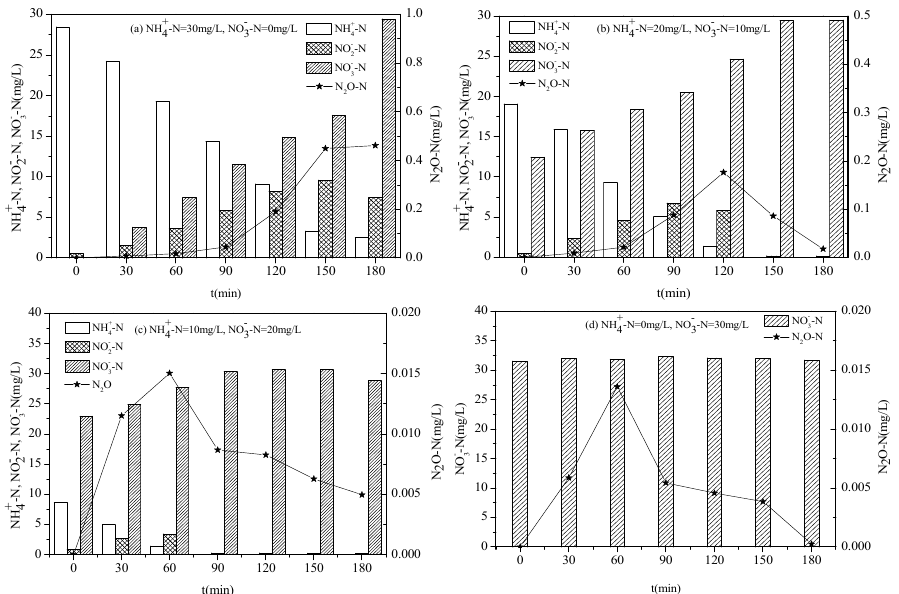
Figure 3. N 2 O emission during full nitrification (full nitrification effluent +NH 4 Cl-N/NaNO 2 -N, DO = 0.5 mg/L).